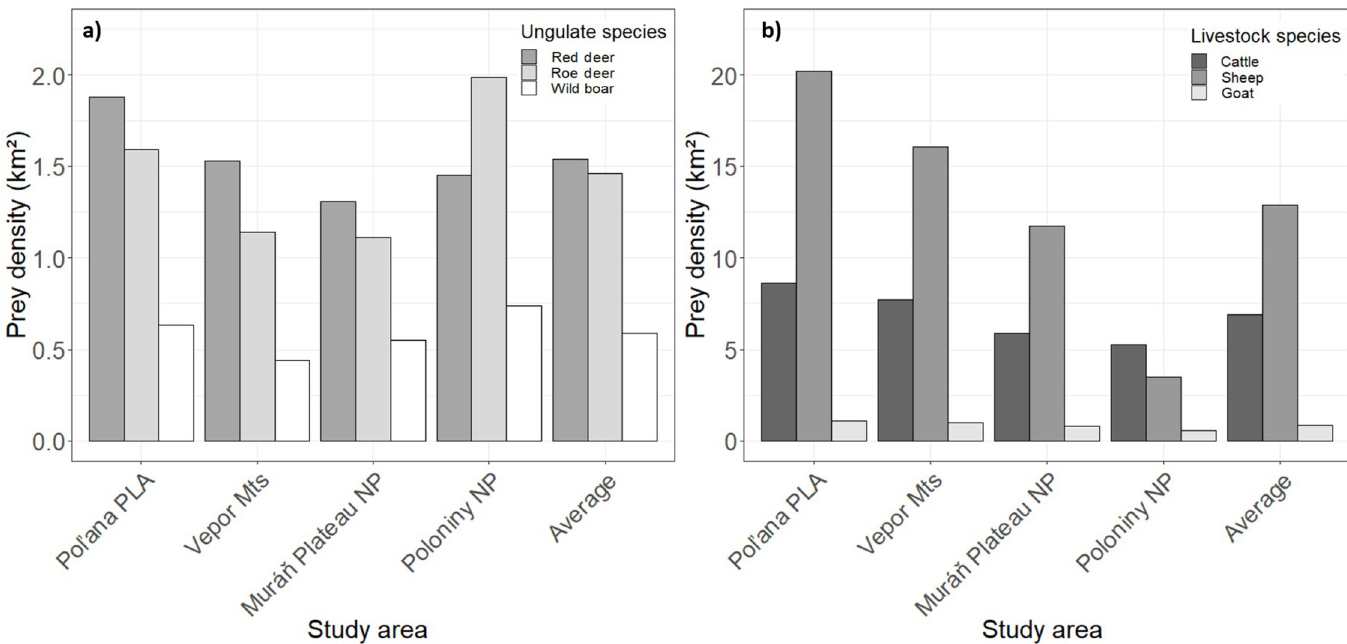
Fig 2. Wild ungulates and livestock densities. Average densities (2015–2017) of wild ungulates (a) and livestock (b) in each of the four study areas in the Slovak Carpathians.